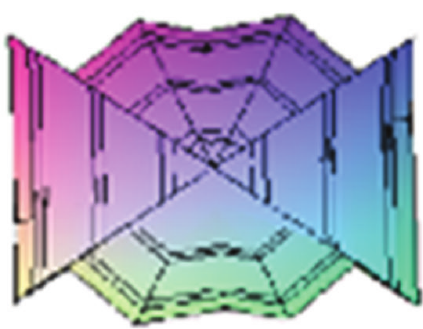
Figure 5: (10, 28, 8/3 , 1).